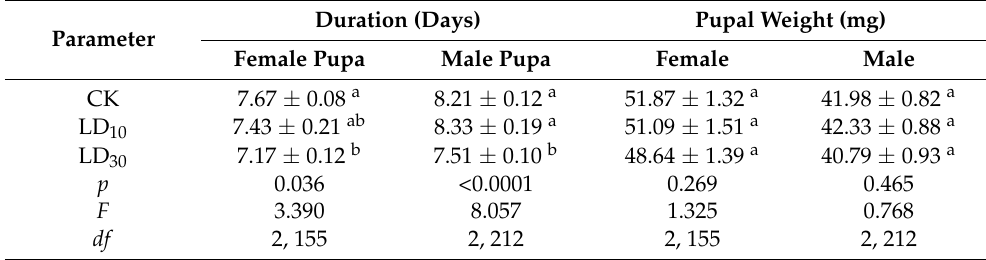
Table 3. Sublethal effect of fluxametamide on duration and weight of F 0 C. suppressalis pupa.